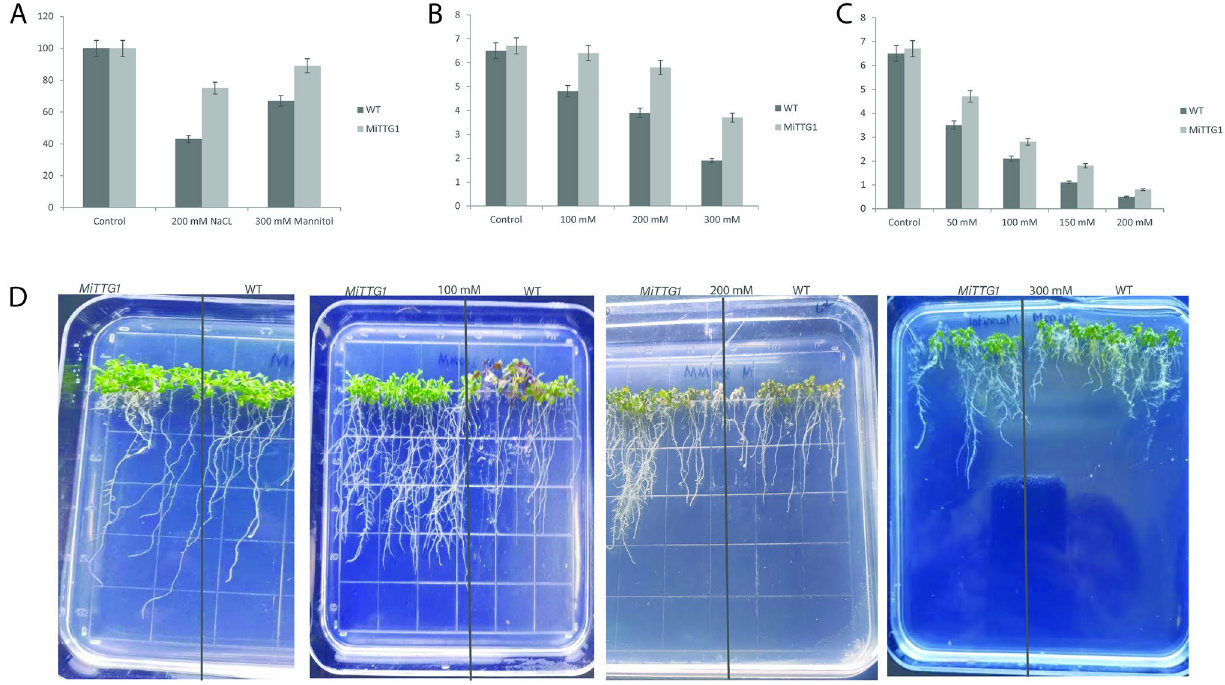
Figure 4. Overexpression of MiTTG1 enhances abiotic stress tolerance. ( A ) Seed germination rate of transgenic lines and wild type on ½ MS supplemented with 300 mM of mannitol and 200 mM for 5 days. ( B ) Root length comparisons of transgenic lines and wild type on ½ MS supplemented with different concentrations of mannitol (control, 100, 200, and 300 mM) for 21 days. ( C ) Root length comparisons of transgenic lines and wild type on ½ MS supplemented with various concentrations of salt (control, 50, 100, 150, and 200 mM) for 21 days. ( D ) Root elongation and root density comparisons of transgenic lines and wild type on ½ MS complemented with mannitol (control, 100, 200, and 300 mM) for 21